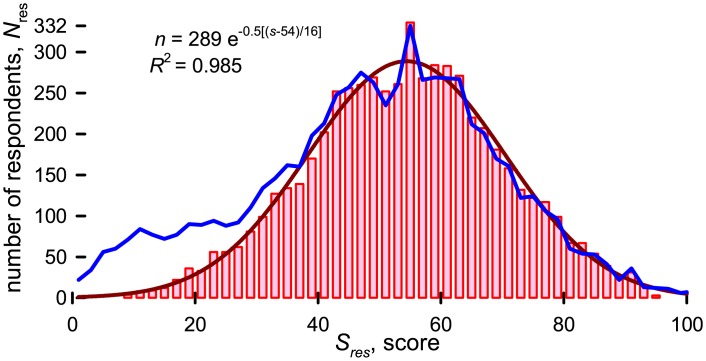
Frequency of individual scores: Blue line includes all responses, N = 6604, and an average score, S, of 48.6; bars represent retained responses, N = 5781 and an average score of 53.7; red line is the best fit Gaussian distribution, R2 = 0.985.